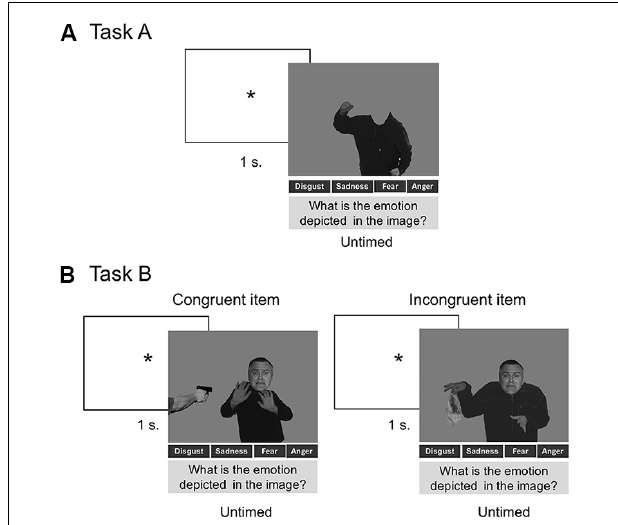
FIGURE 1 | Panel (A) shows the procedure of Task A. Panel (B) shows the procedure used in Task B, including a trial with a congruent item and a trial with an incongruent item. The stimuli of this procedure were adapted from Aviezer et al. (2008). Reproduced with permission from Aviezer et al. (2008). ∗ Indicates attention fixation